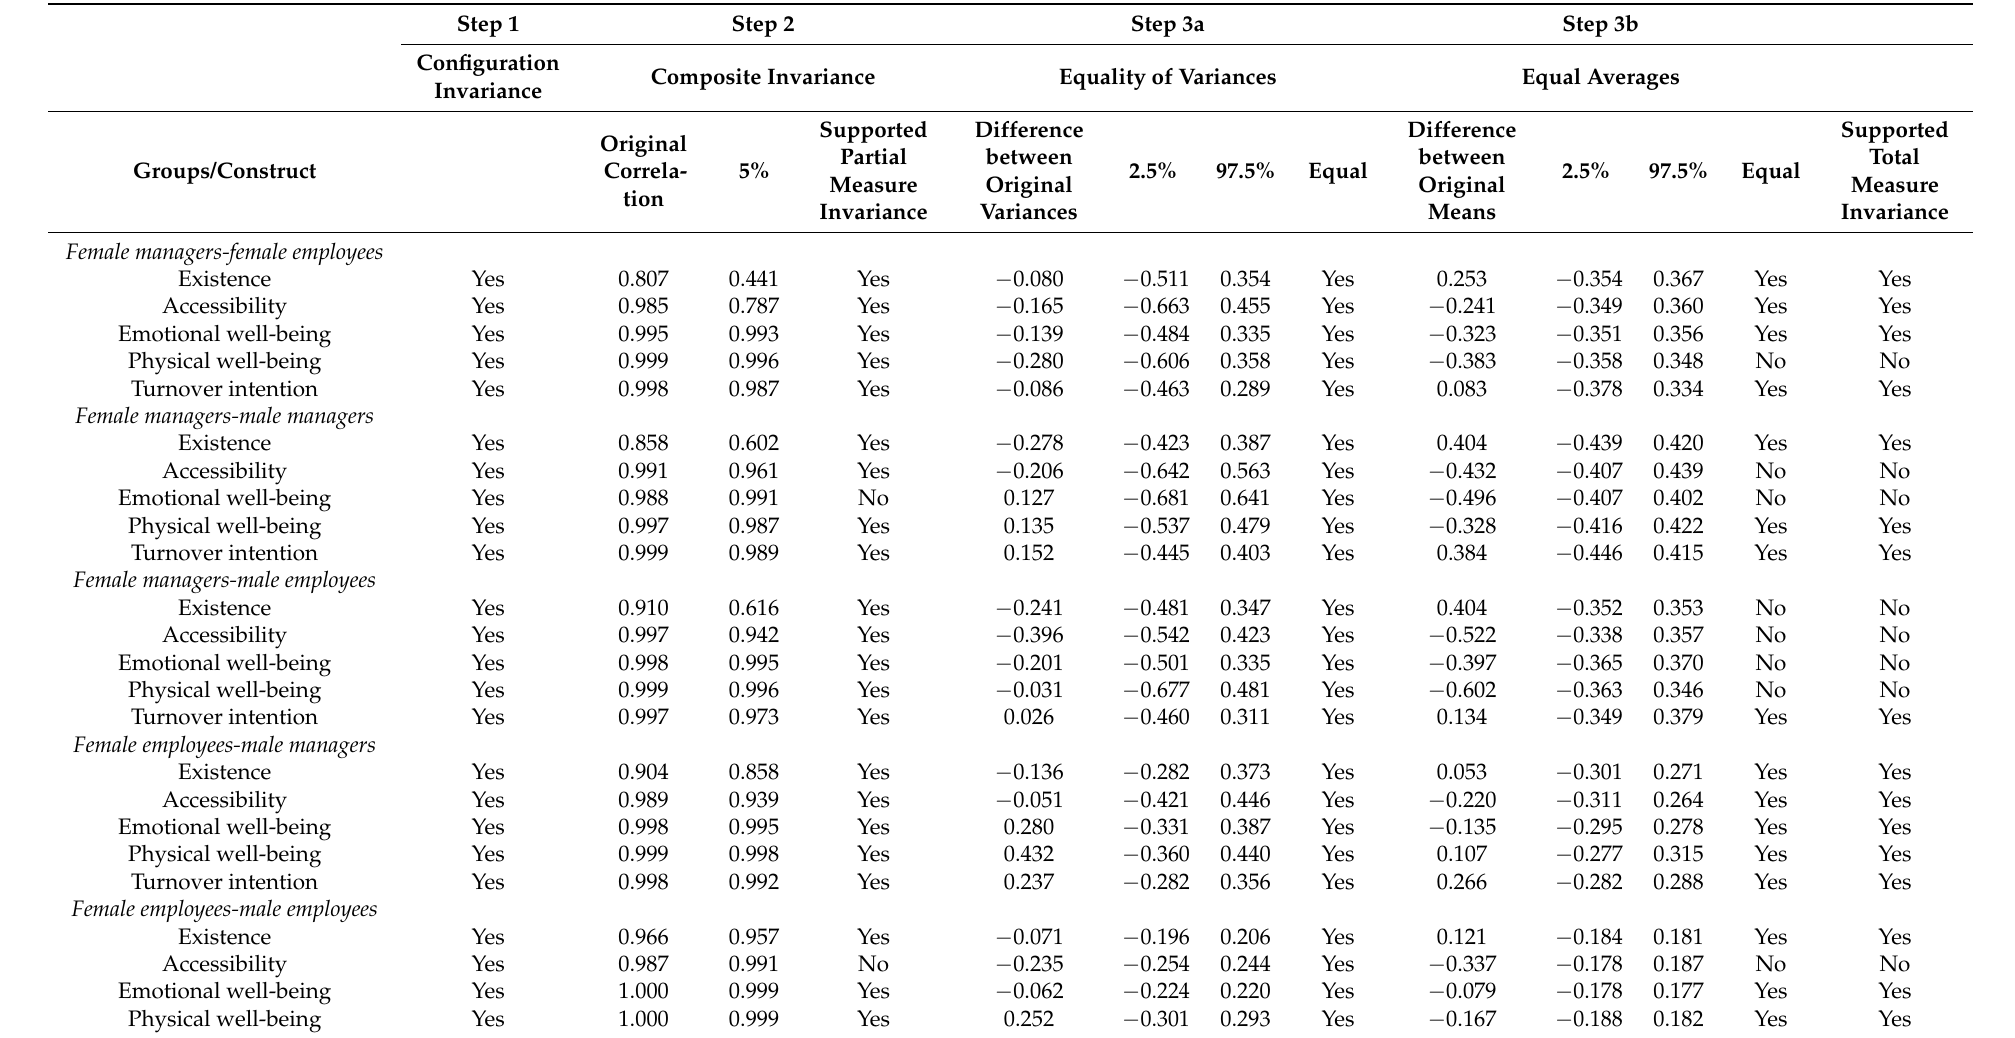
Table 5. Results of the measurement invariance assessment